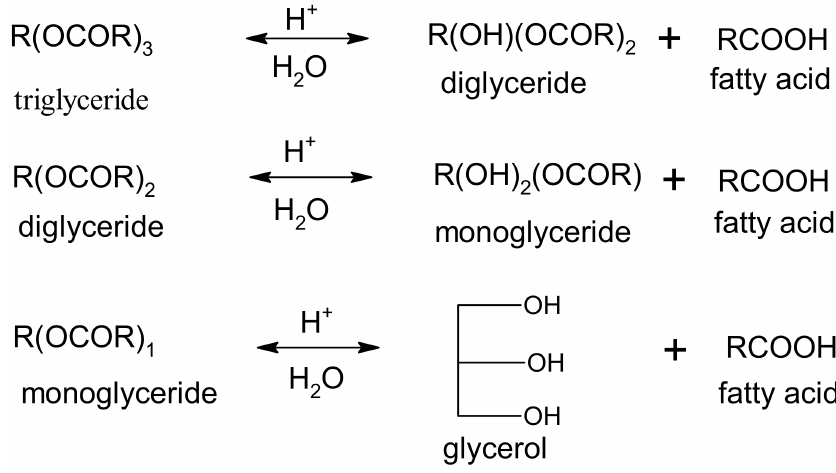
Figure 2. Plausible hydrolysis reaction.